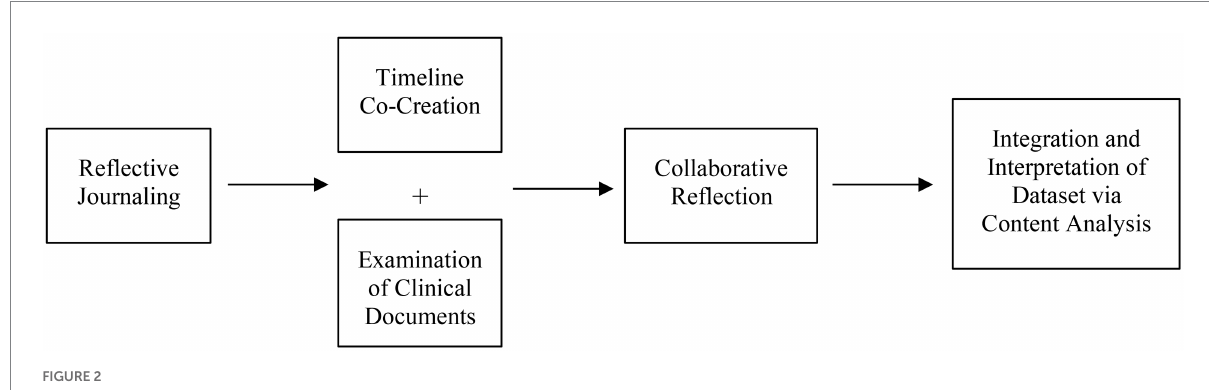
FIGURE 2 Data collection and